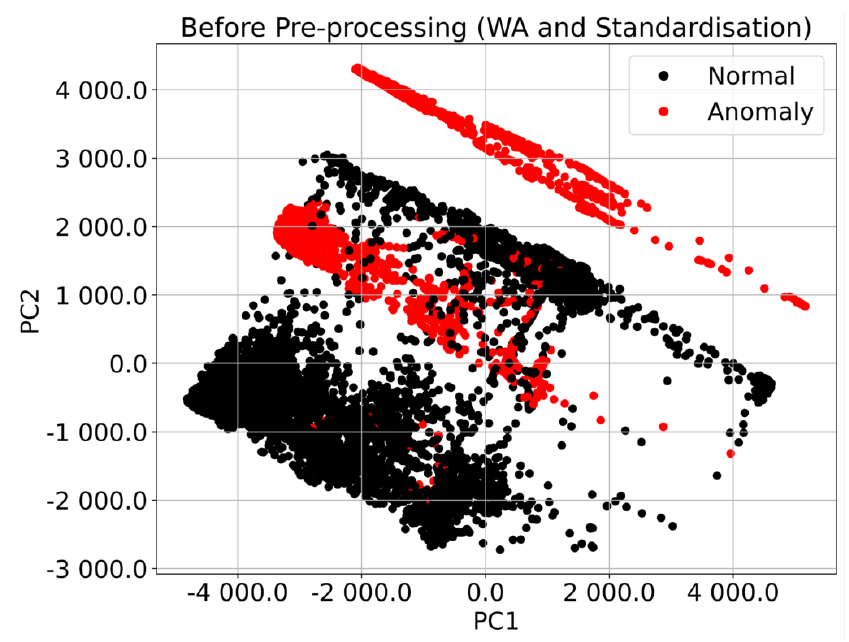
Figure 11. The first two principal component plots of the labelled